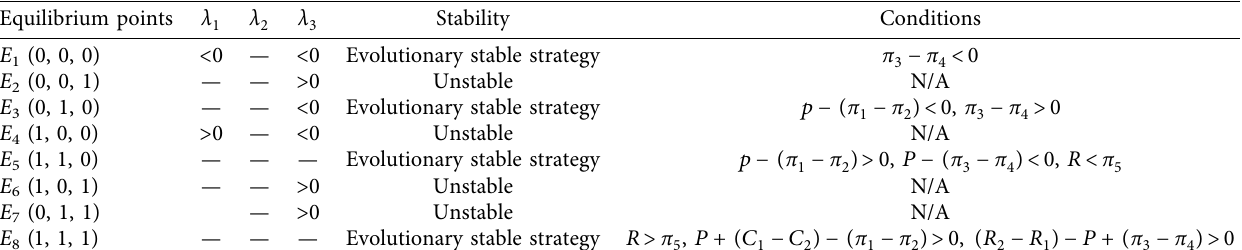
Table 4: Stability of the equilibrium points in Case 2.